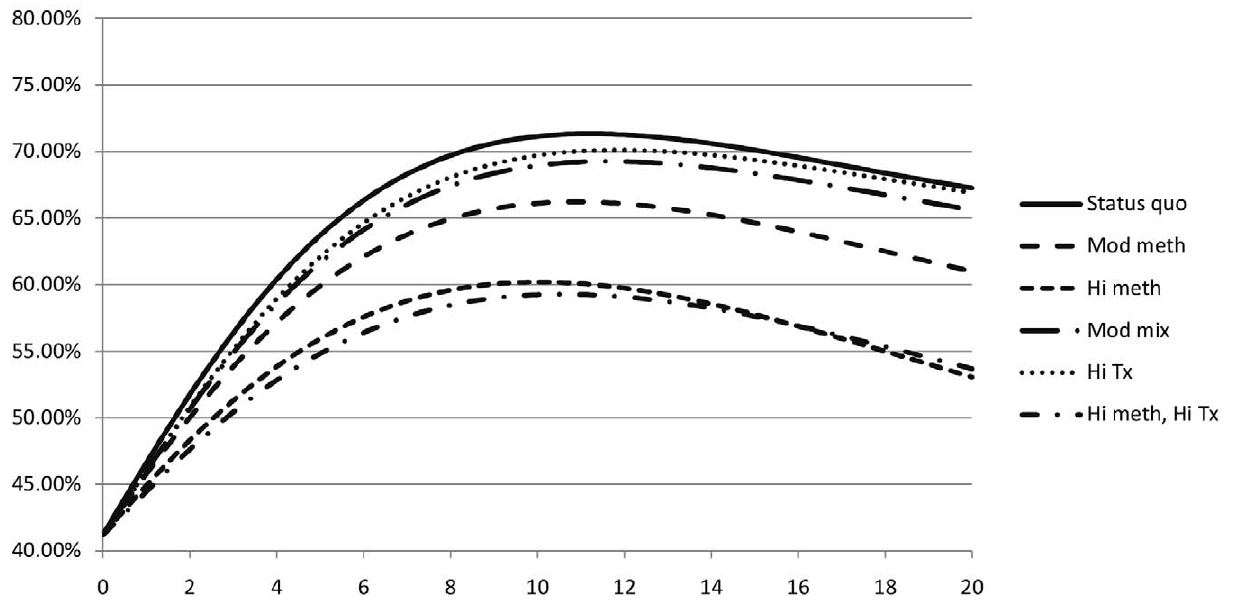
Figure 1. Evolution of estimated HIV prevalence among IDUs in Ukraine for various strategies to expand methadone substitution therapy and ART access. Status quo, no methadone substitution therapy slots, 10% of eligible non-IDUs on ART, 2% of eligible IDUs on ART; Mod meth, 12.5% of IDUs on methadone substitution therapy, ART according to status quo except 25% of eligible IDUs on methadone substitution therapy on ART; Hi meth, 25% of IDUs on methadone substitution therapy, ART according to status quo except 25% of eligible IDUs on methadone substitution therapy on ART; Mod mix, 3.1% of IDUs on methadone substitution therapy, 50% of all eligible patients on ART; Hi tx, no methadone substitution therapy slots, 80% of all eligible patients on ART; Hi meth, Hi tx, 25% of IDUs on methadone substitution therapy, 80% of all eligible patients on ART.